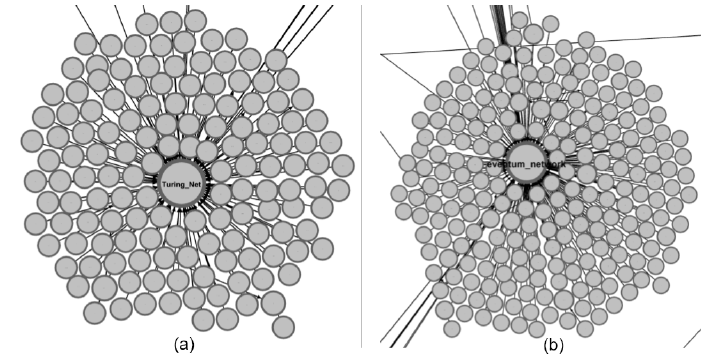
Figure 7. Examples of small clusters of users—( a ) Turing Net AI Platform and ( b ) Eventum